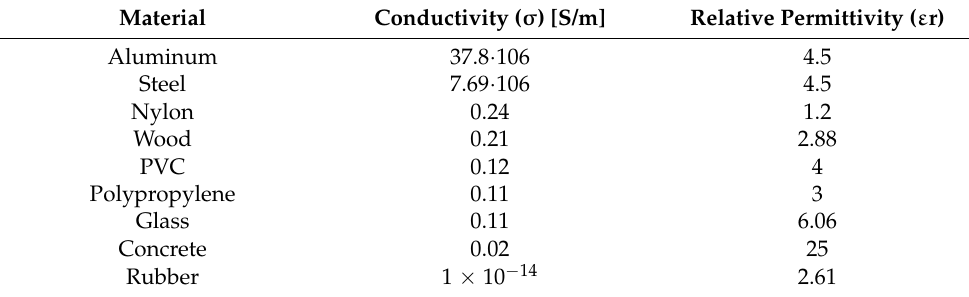
Table 3. Material Properties for 3D Ray Launching Simulations [13].